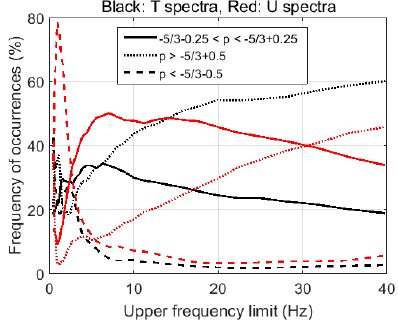
Figure 6. Frequency of occurrences of ranges of slopes vs. f max for T spectra (black) and U spectra (red)